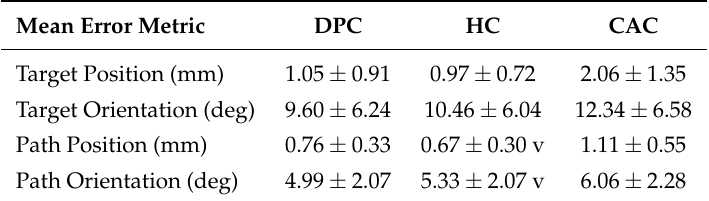
Table 3. User trial results.